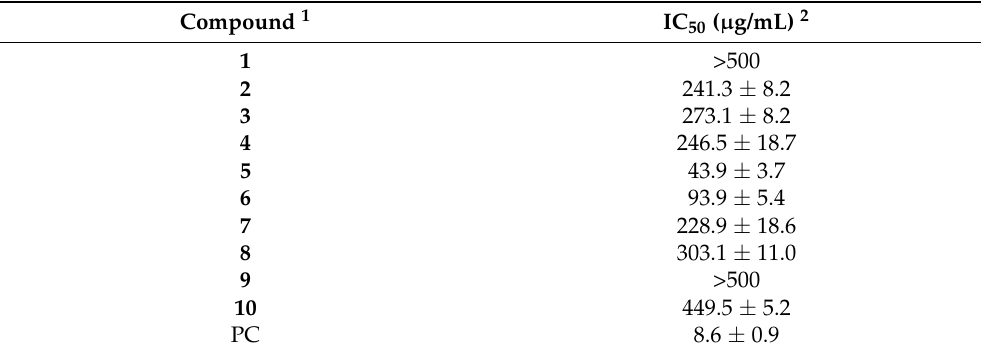
Table 1. Half-maximal inhibitory concentration (IC 50 ) for the inhibition of NO production by the isolated compounds from Millettia speciosa . Compound 1